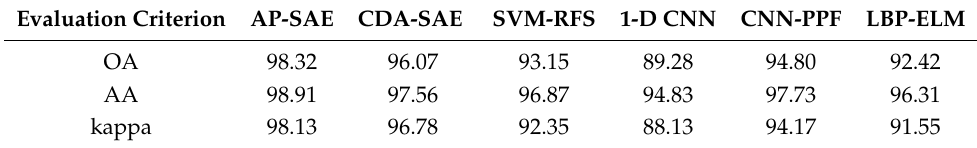
Table 7. Performance Comparison of Different Thresholds for Salinas.